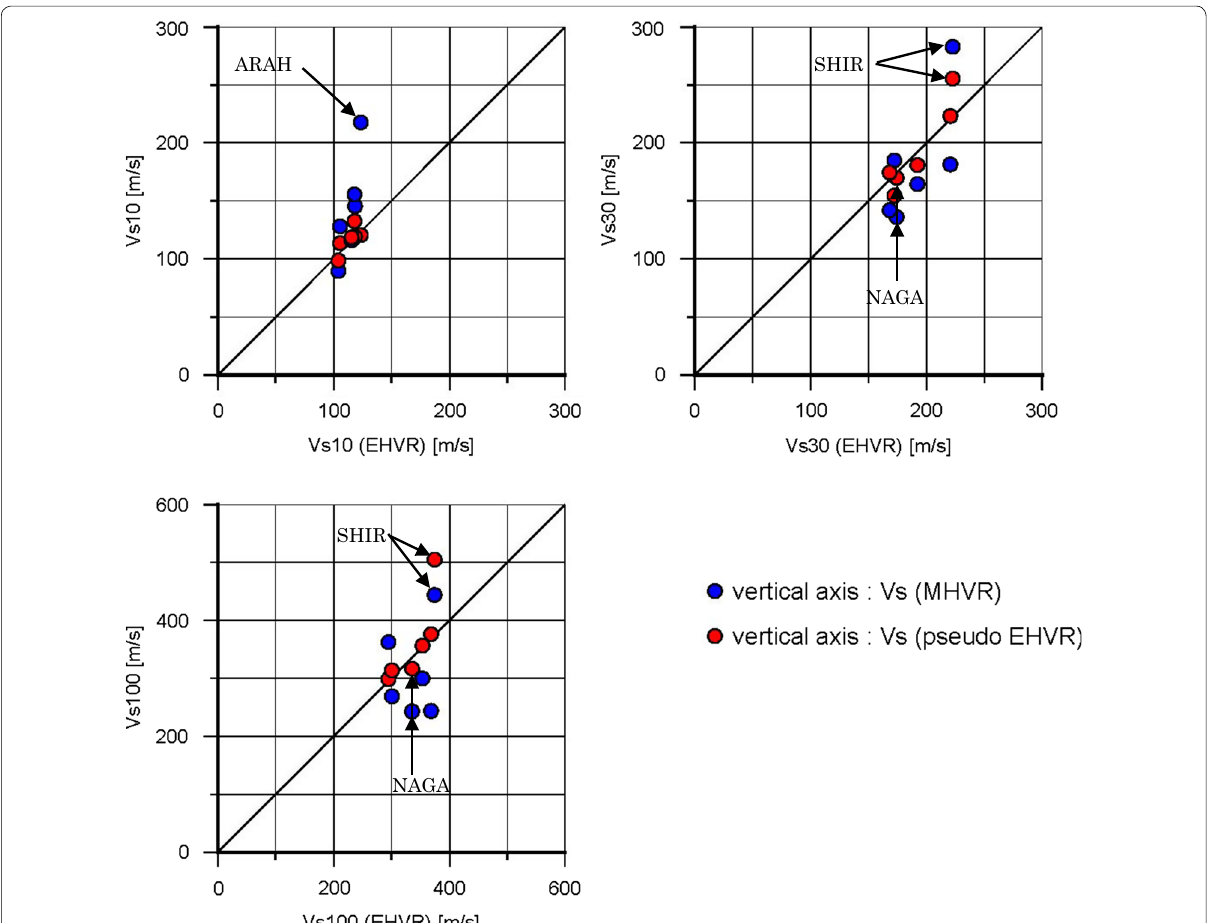
Fig. 24 Comparison of the averaged velocities from pEHVR inversion or MHVR inversion (vertical axis) with respect to those from EHVR inversion (horizontal axis). Each panel shows those for top 10, 30, and 100 m with a priori constraints. Several outliers’ site codes are shown